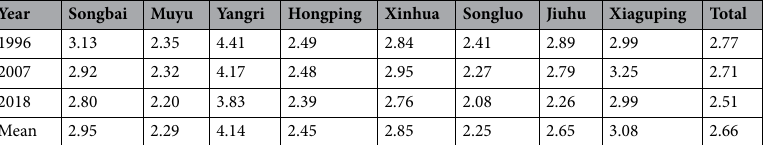
Table 5. Comprehensive ecological vulnerability index of